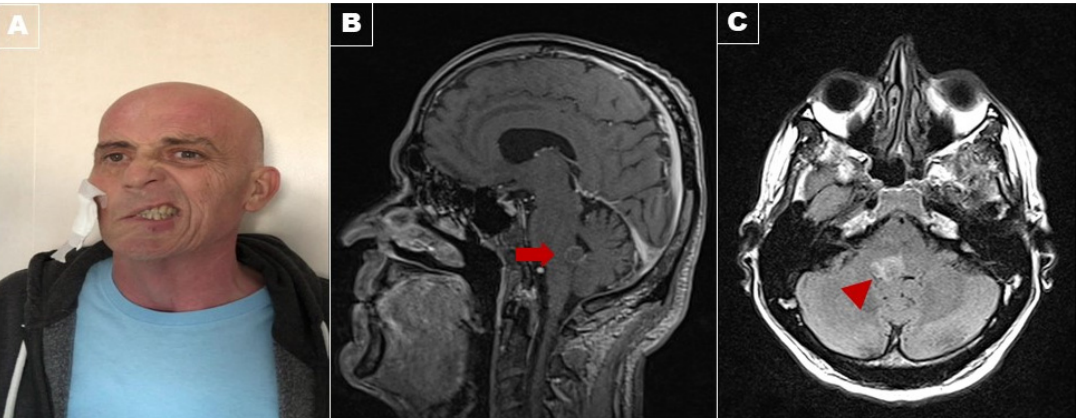
Figure 1. Panel ( A ): The patient showed severe right facial palsy with a peripheral pattern with Bell’s sign, rightward conjugate gaze palsy, and right internuclear ophthalmoplegia. The leftward gaze evoked left-beating nystagmus. Postcontrast T1-weighted Magnetic resonance imaging in the sagittal view (Panel ( B )) demonstrated a ring enhancement lesion (arrow) on fluid-attenuated inversion recovery (FLAIR) in the axial view (arrowhead; Panel ( C )) in the dorsal tegmentum of the pons, suggestive of metastasis.